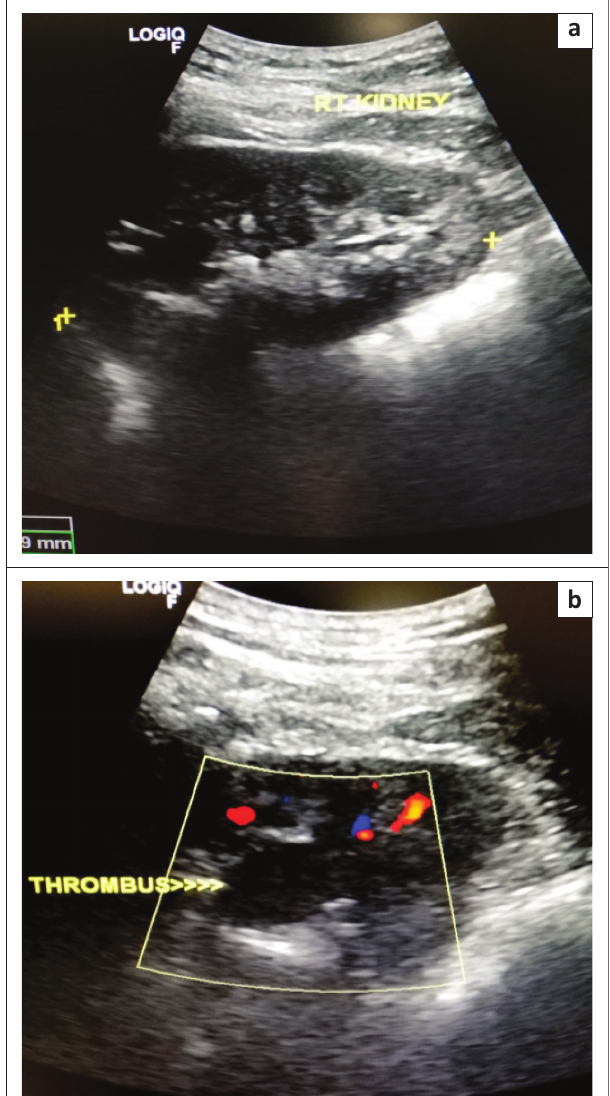
FIG URE 6: Post-embolisation Ultrasound and Doppler demonstrating a thrombus in the feeding artery and absence of venous flow 4 weeks after the procedure: (a) Post-embolisation Ultrasound of the right kidney showing a thrombus in the feeding artery at the right upper pole. (b) Post-embolisation Colour Doppler demonstrating absence of venous